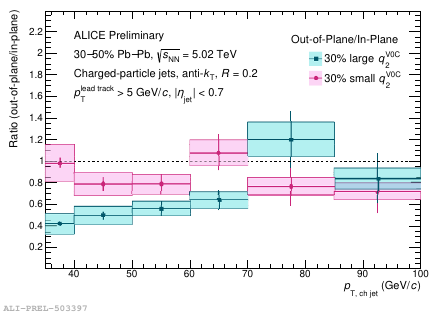
Figure 2. Ratio of R = 0 . 2 jet yields measured in-plane and out-of-plane, for high and low q 2 events, measured in semi-central 30 − 50% Pb–Pb collisions by